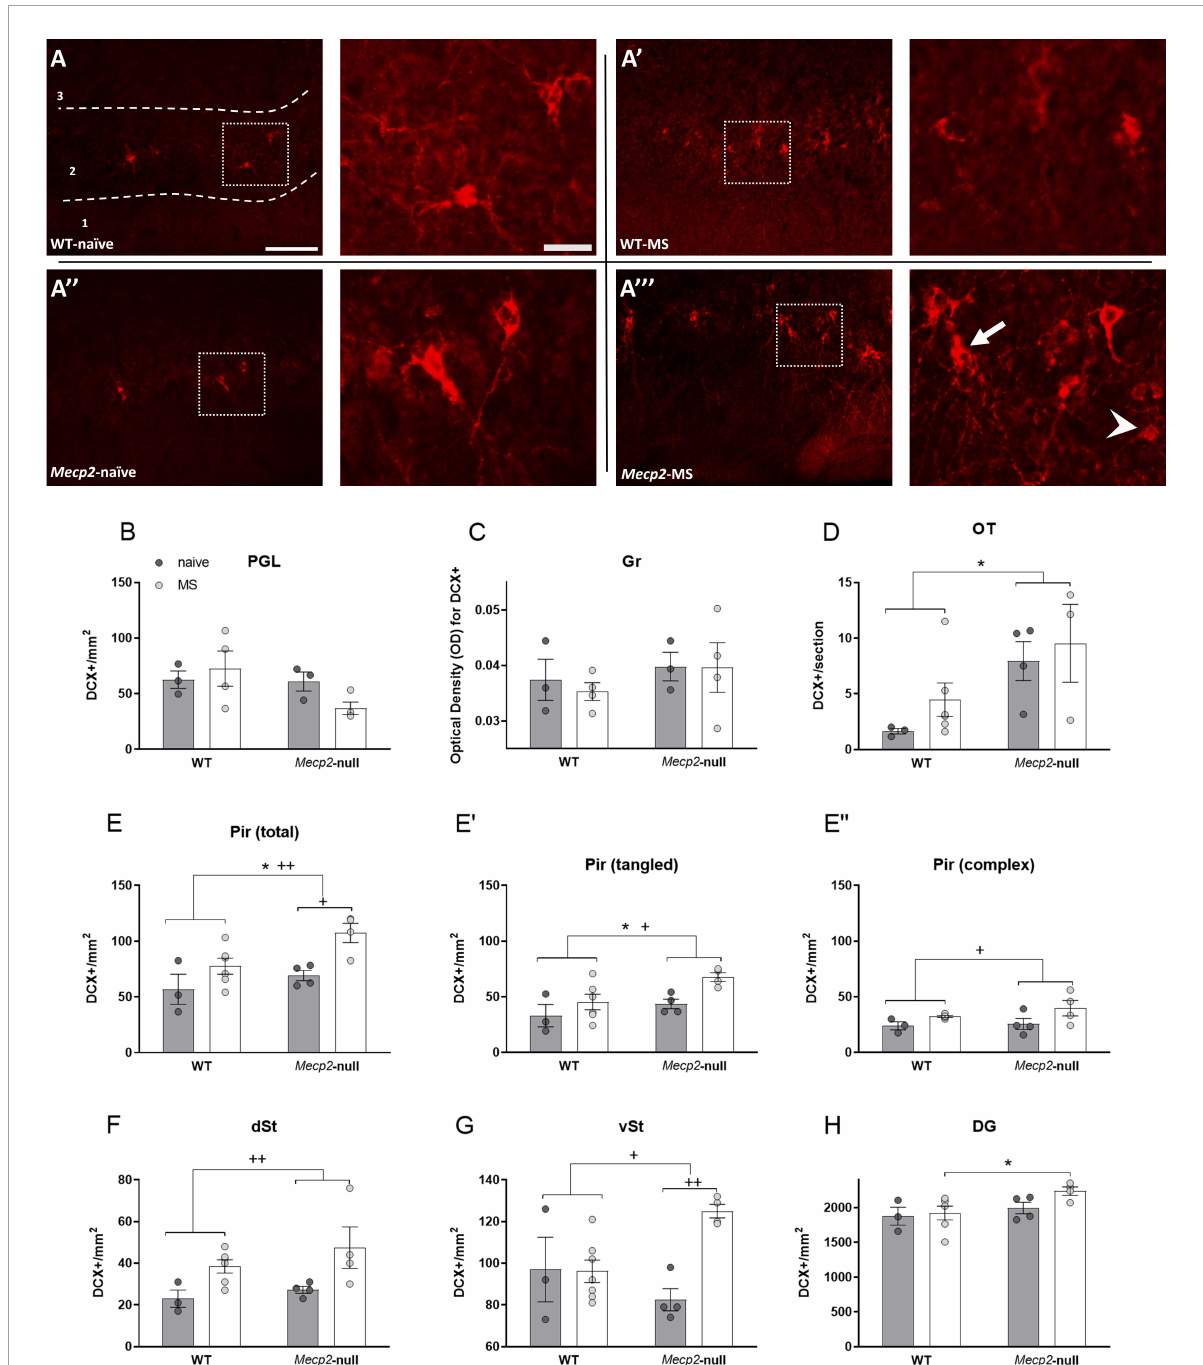
FIGURE5 Lack of Mecp2 increases the number of DCX positive cells in a region-specific manner and MS further exacerbates this effect. (A) Representative photomicrographs from DCX immunostaining (red) at the Pir from WT-naïve (A) , WT-naïve, WT-MS (A’), Mecp2 -null-naïve (A”) and Mecp2 -null-MS at 10 × (left panel) (scale bar 100 µ m) and a higher magnification at 20 × (right panel) (scale bar 25 µ m) Arrow points to a complex and arrowhead to a DCX-ir tangled representative DCX-ir neurons. In the OB: density of DCX-ir cells at the PGL (B) and OD for DCX at the Gr (C) . (D) DCX-ir cells in OT and (E) . total density of DCX-ir in the Pir, and in the tangled (E’) and complex DCX-ir cells only (E”) . Number of DCX positive cells at (F) dSt and (G) vSt. Number of DCX-ir cells in the DG when comparing animals from the MS groups (H) . All graphs show individual values and mean ± SEM. * p < 0.05 by genotype; + p < 0.05, ++ p < 0.01 by group. DCX, doublecortin; DG, dentate gyrus of the hippocampus; dSt, dorsal striatum; Gr, granular layer of the olfactory bulb; OB, olfactory bulb; OT, olfactory tubercle; PGL, periglomerular layer of the olfactory bulb; Pir, piriform cortex; vSt, ventral